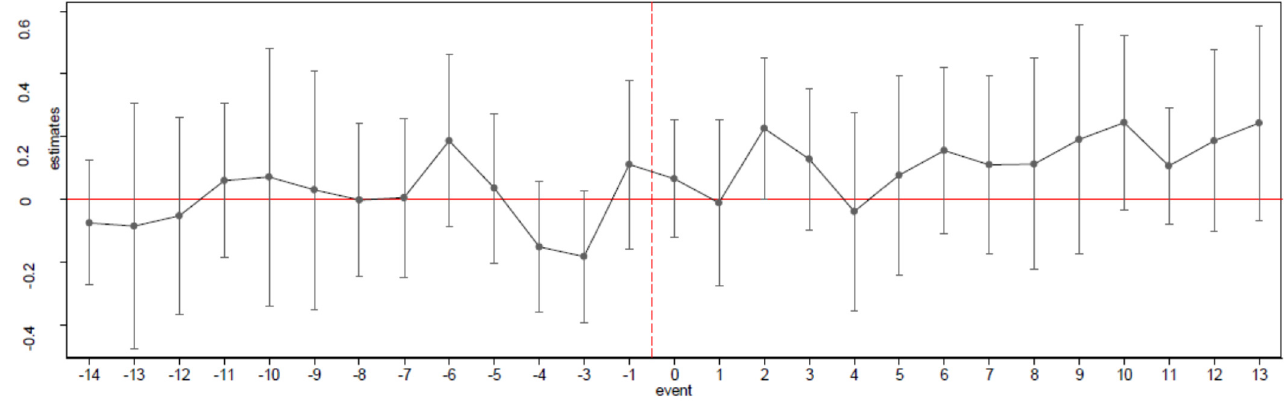
Figure 9. Parallel Trends Analysis—Event Studies on Loans Granted—Tourism Sector.